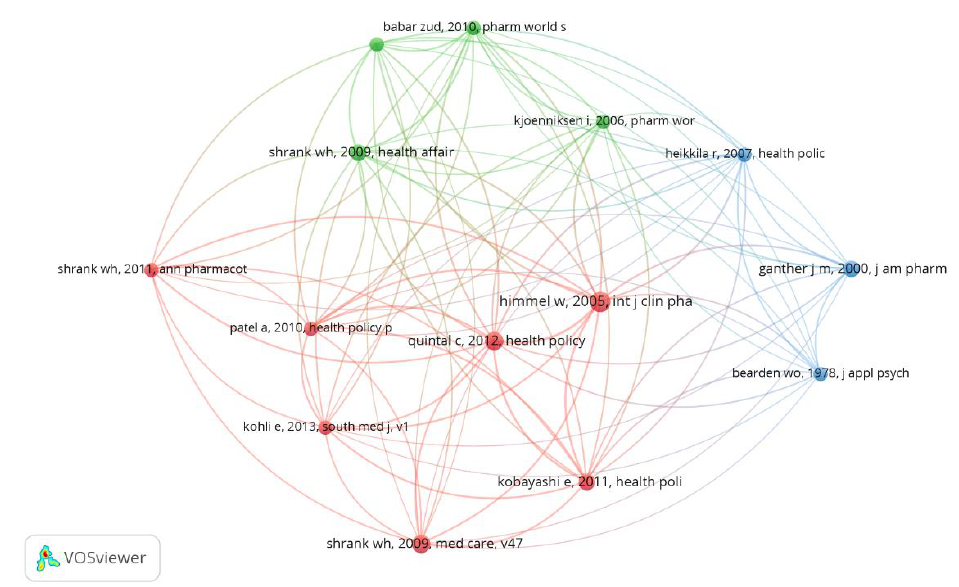
Figure 4. Networks for co-citing references. Table 4. Cluster with co-citations of references.